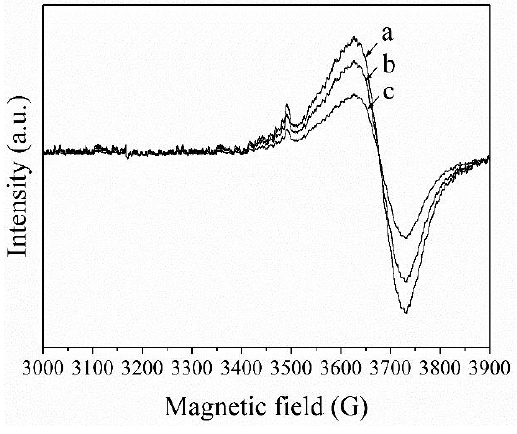
Figure 8: ESR spectra of: a – PWA/P (2VPco1MA), b –